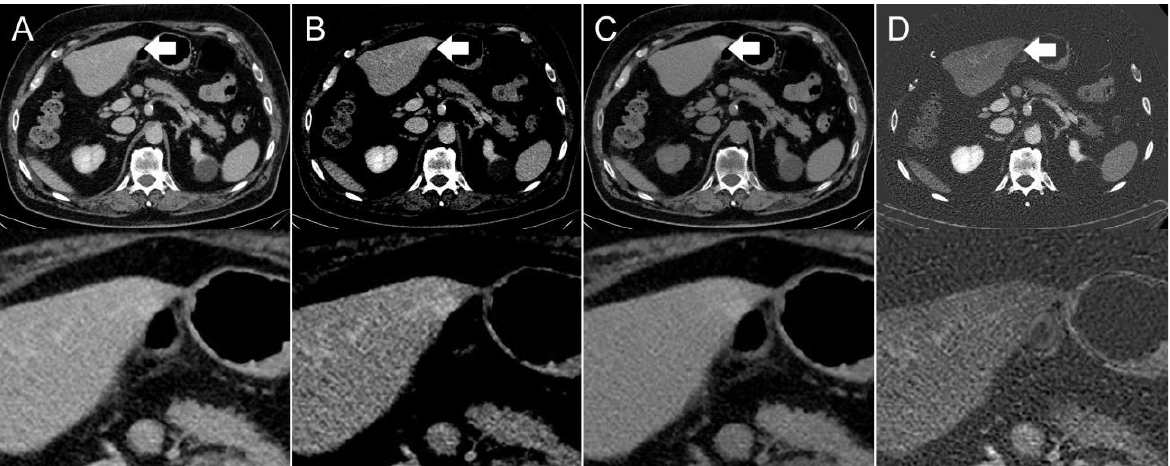
Figure 3. Axial contrast-enhanced CT scan of a 67-year-old man. Hyperdensity (indicated by arrows) on the left liver lobe in the ( A , B ) conventional 120 kVp image using an ( A ) abdomen window and ( B ) liver window, which might be interpreted as a hyperenhancing liver lesion. The ( C ) virtual non-contrast (VNC) image reconstruction and ( D ) iodine image reconstruction reveal that it is not a hyperenhancing liver lesion, but a streak artifact originating from the stomach